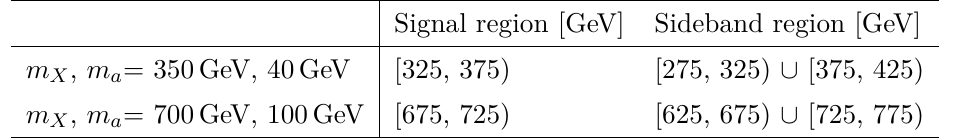
√ ˆ s that define the analysis signal and sideband regions.